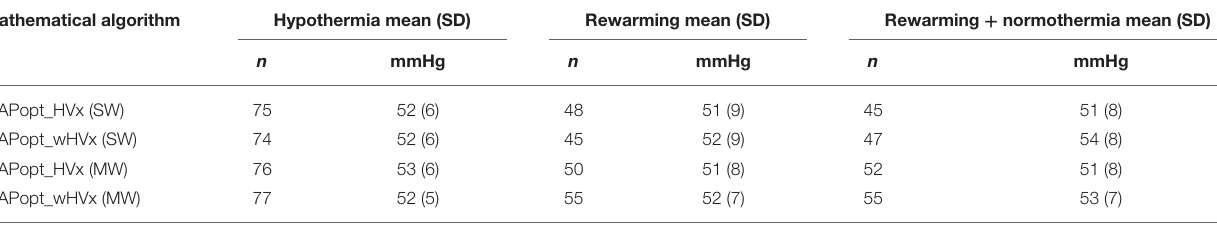
TABLE 3 | Mean optimal arterial blood pressure values identified by the autoregulation metrics. Mathematical